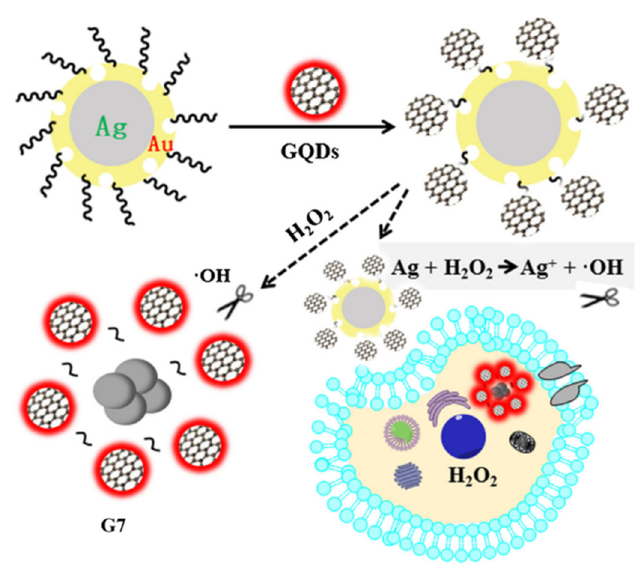
Figure 9. Schematic representation of the fabrication of Ag@AuNPs-DNA/GQDs ( G7 ) and the H 2 O 2 sensing mechanism in living cells. Reprinted from [62] with permission from Springer.